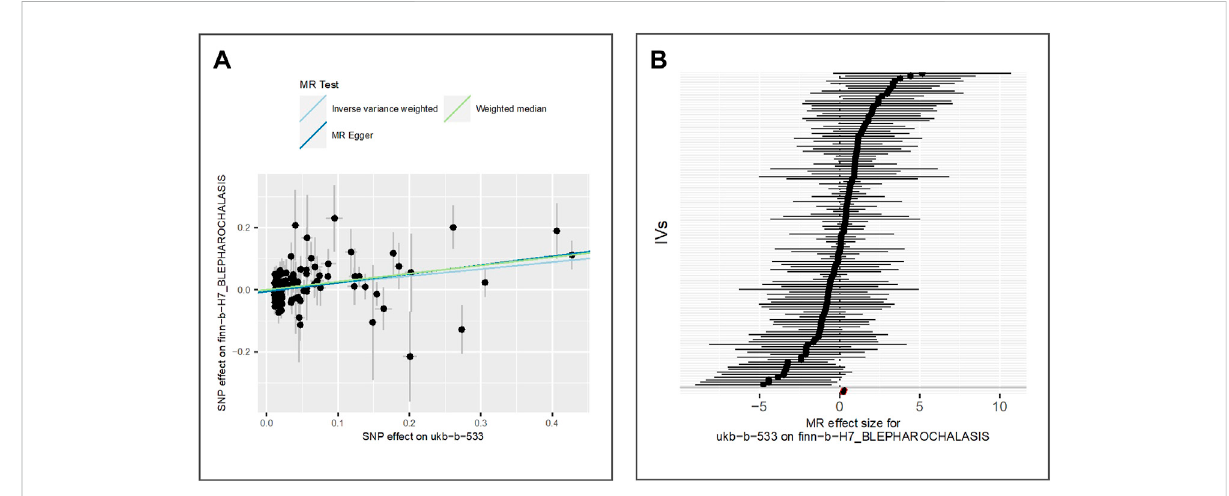
FIGURE 4 Comparison of MR methods and results associated with blepharochalasis: (A) scatter plot re fl ects SNP effects on the blepharochalasis against SNP effects on the exposure; (B) forest plot represents the causal effect of exposure on the outcome using each SNP